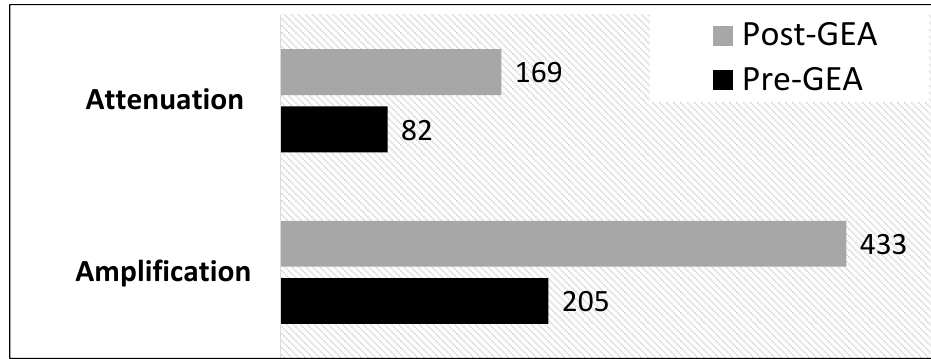
Figure 4. Prominence of reported amplifications and attenuations pre- and post-GEA.